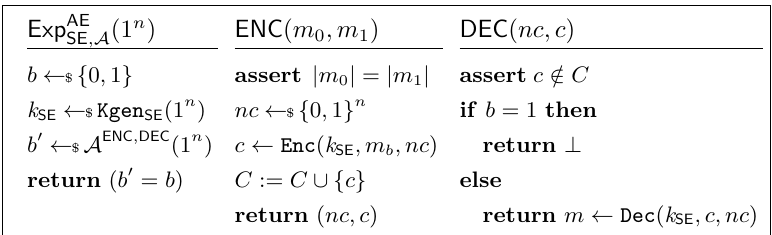
(1 n ) security SE , A